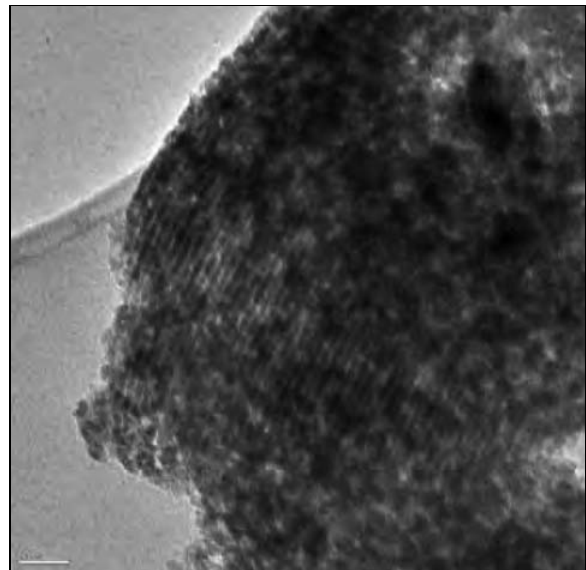
Figure 1. TEM image of NH